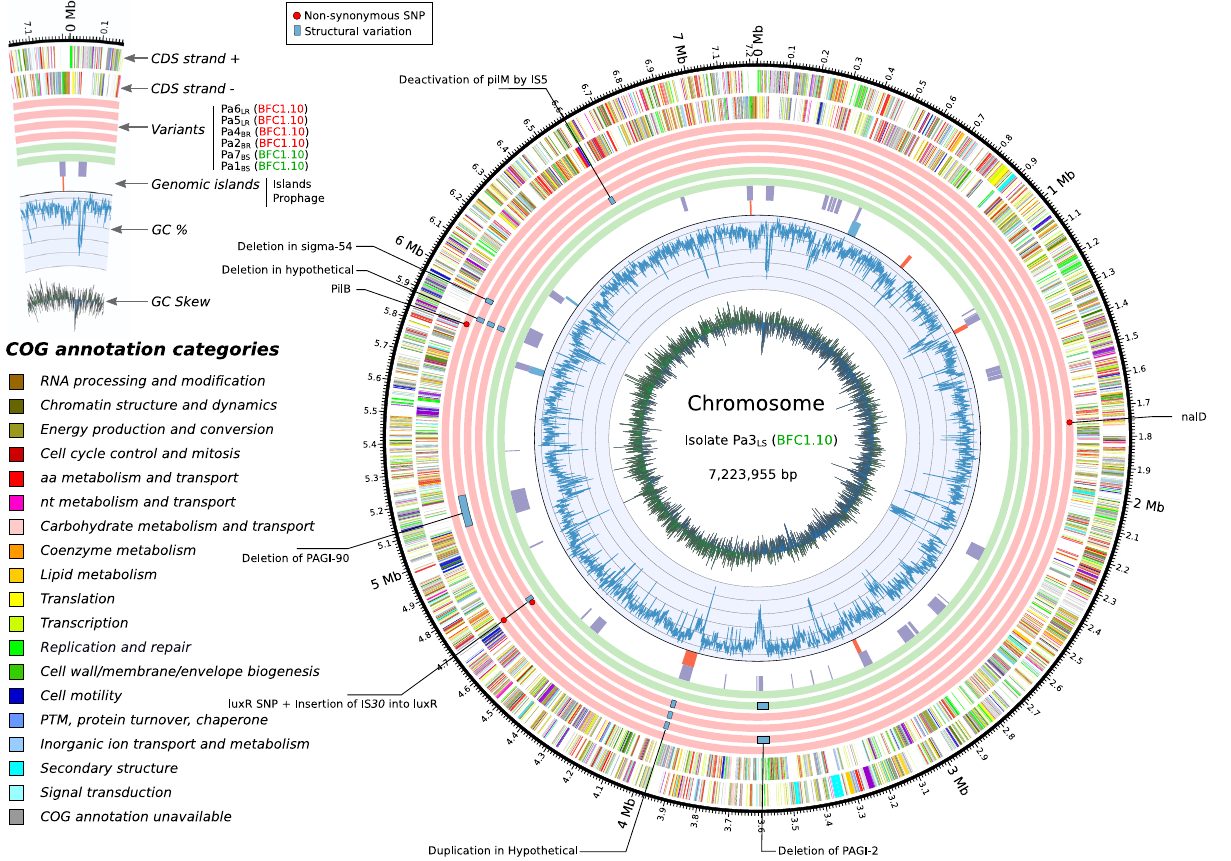
Fig. 2 | Circular chromosomic view (CCV) of the bacterial genomes of seven Pseudomonas aeruginosa isolates retrieved just before (Pa1 BS ) and during